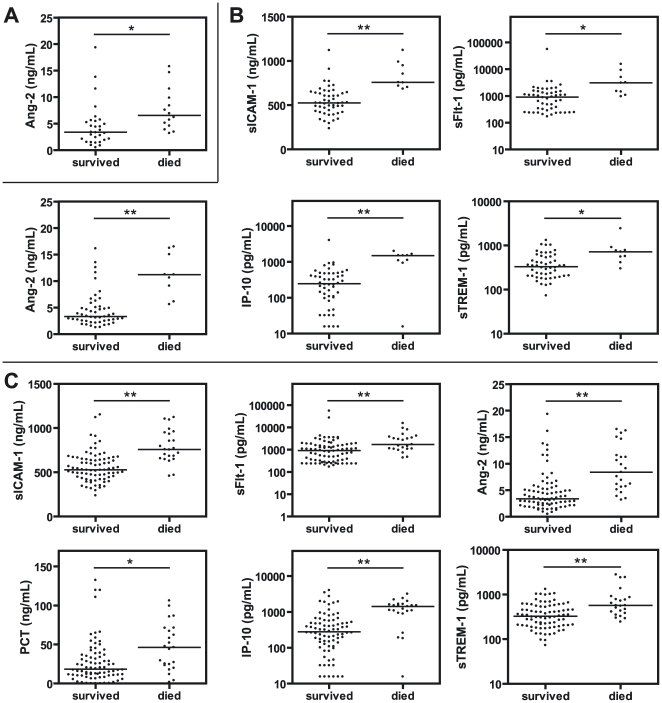
Plasma biomarker levels in children with severe malaria who survived or subsequently died from infection.Presented are biomarkers that were significantly different for (A) CM patients only, (B) SMA patients only, and (C) all severe malaria patients combined. Biomarkers were measured by ELISA. Data are presented as dot plots with medians. A Mann Whitney U test was performed for each comparison, and p values were adjusted for multiple comparisons using Holm's correction (n = 12 for each group). * p<0.05 and ** p<0.01.